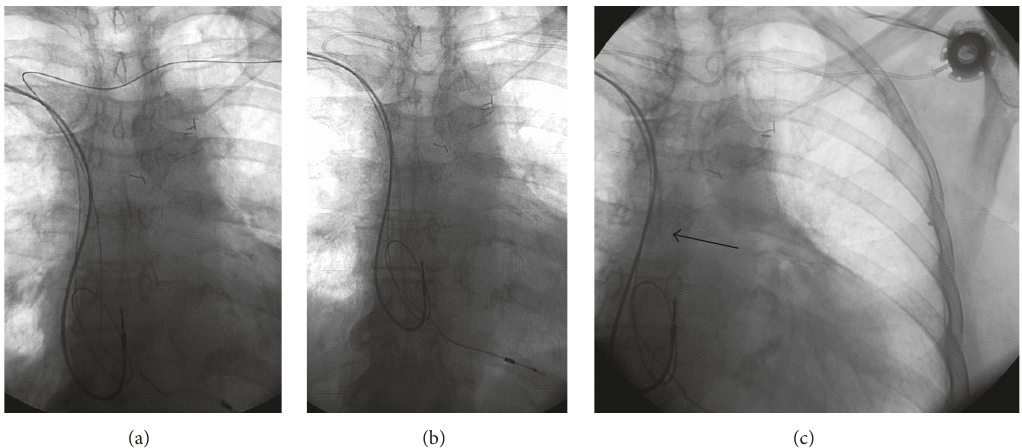
Figure 3: Fluoroscopy-guided images showing guidewire (a) and catheter (b) placement into the inferior vena cava and final positioning of the venous port system